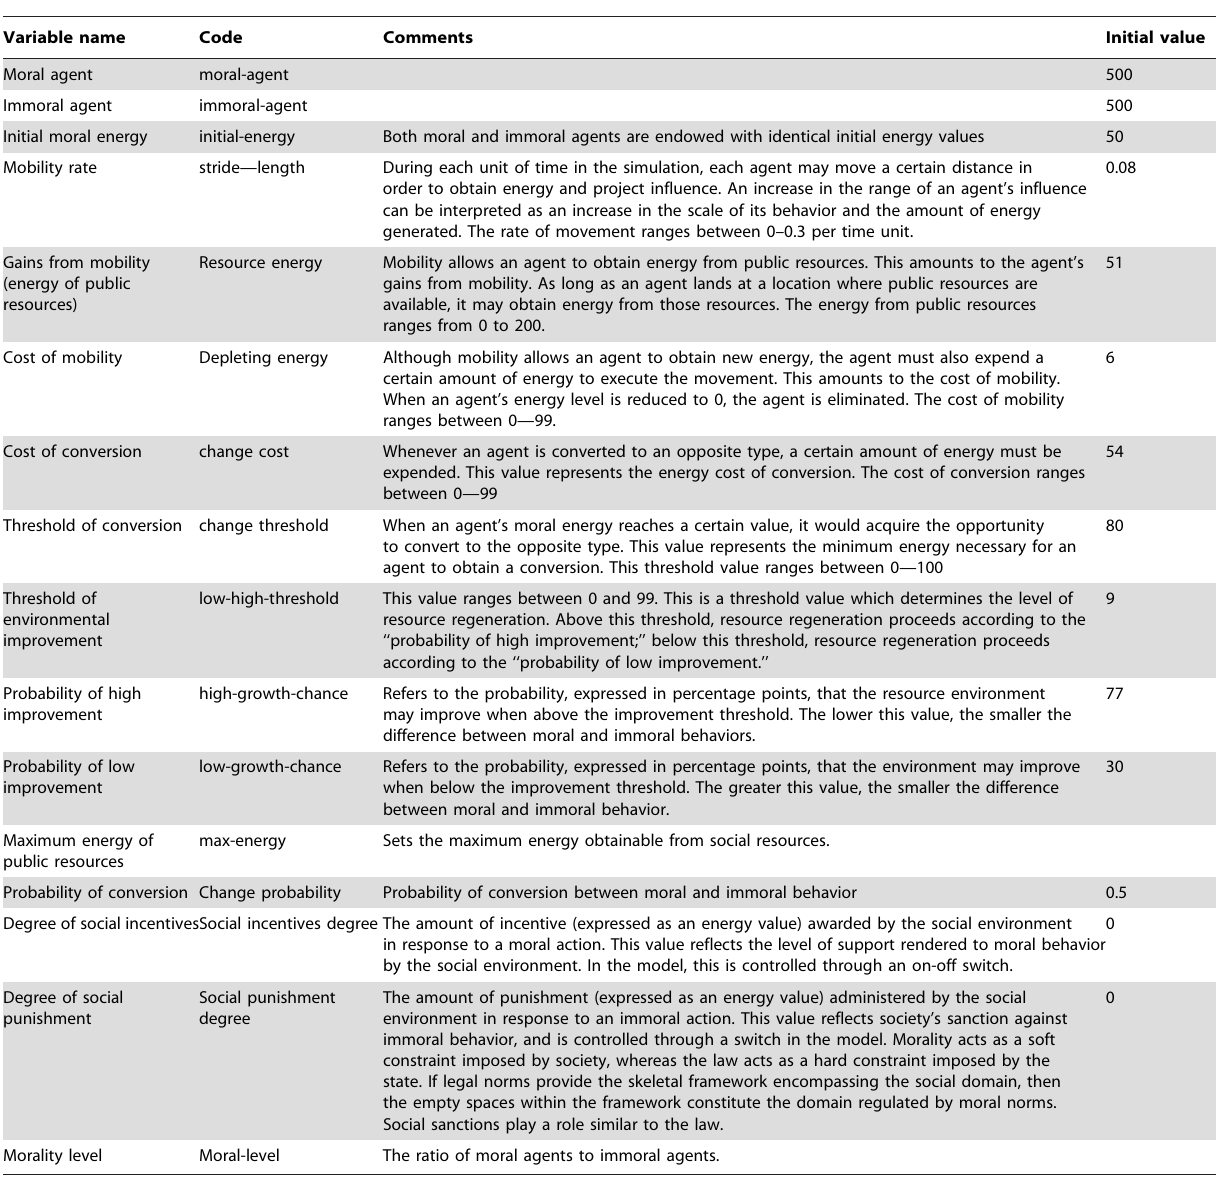
Table 1. Model Parameters and Initial